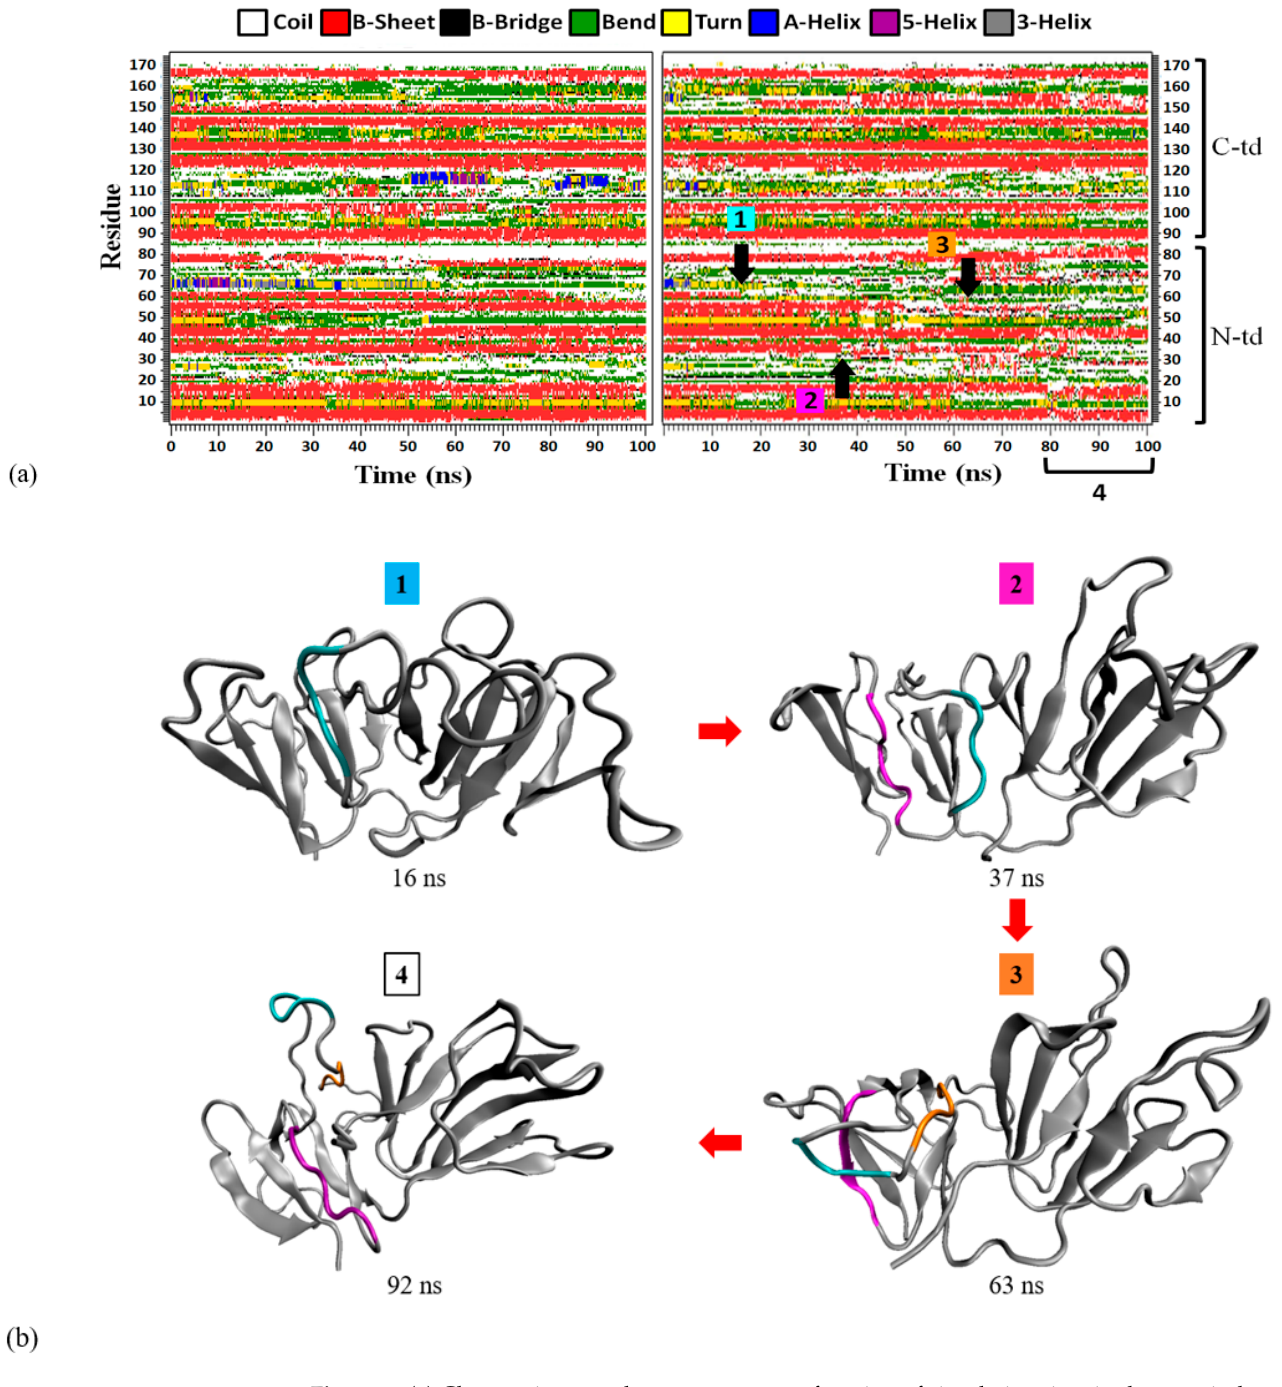
Figure 8. ( a ) Changes in secondary structure as a function of simulation time in the urea-induced (left panel) and GdnHCl-induced (right panel) conformers. The loss of important β -strands in the initial stages of GdnHCl-induced structural unfolding are indicated by black arrows and numbered with respect to the sequence of time with which they occurred. Number 4 indicates a range of time corresponding to near-complete melting of motif 2. ( b ) The important β -strand loss in the 3D GdnHCl-induced conformer extracted from the indicated time frame are color-coded in accordance with the color code presented in ( a ). The important β -strand loss corresponds to regions of G61~A64 (cyan), C33~V38 (magenta), and Q55~L58 (orange). A representative 3D structure indicated by number 4 shows the near-complete melting of Greek key motif 2 in the range of time corresponding to the last 20 ns of